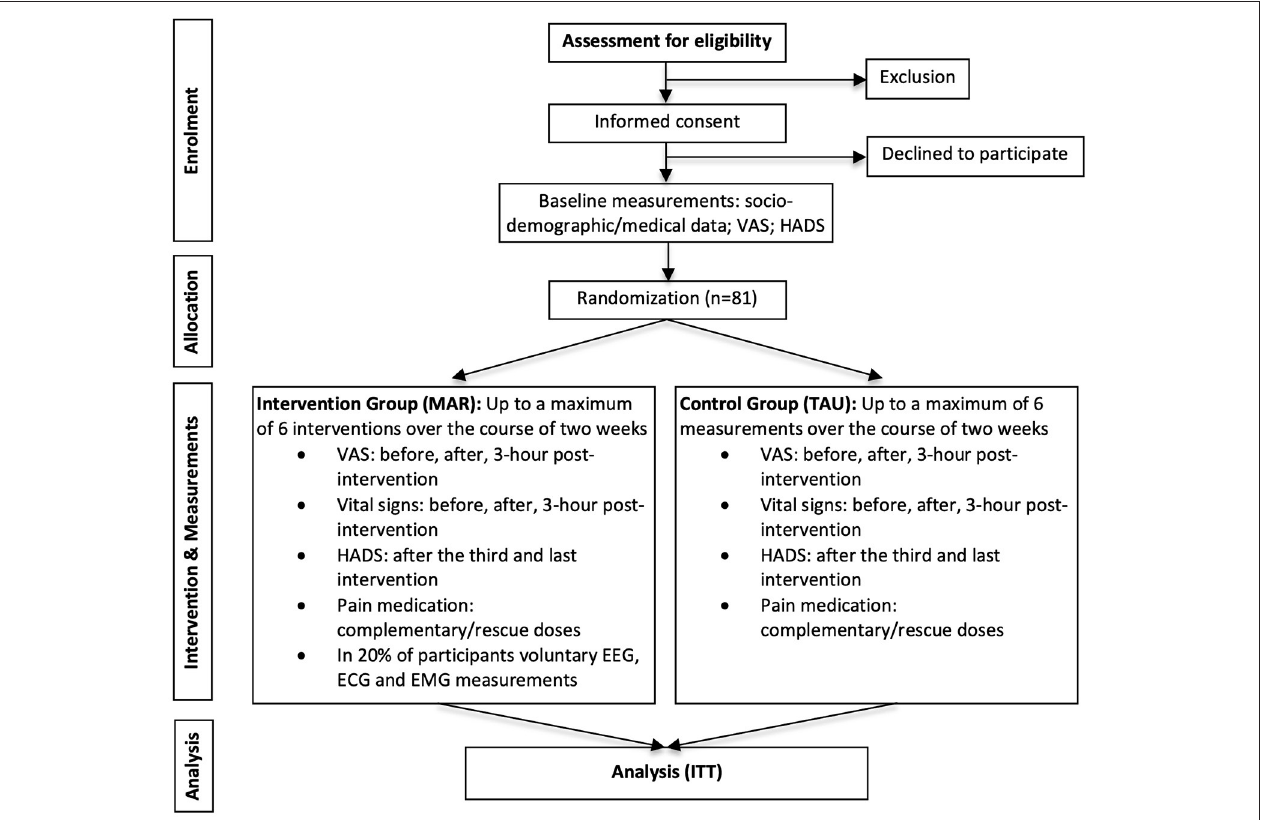
FIGURE 1 | Flow-diagram. Flow-diagram adapted from Schulz et al. (34). VAS, Visual Analog Scale; MAR, Music Assisted Relaxation; TAU, Treatment as usual; EEG, Electroencephalography; ECG, Electrocardiography; EMG, Electromyography; ITT, Intention-to-treat.